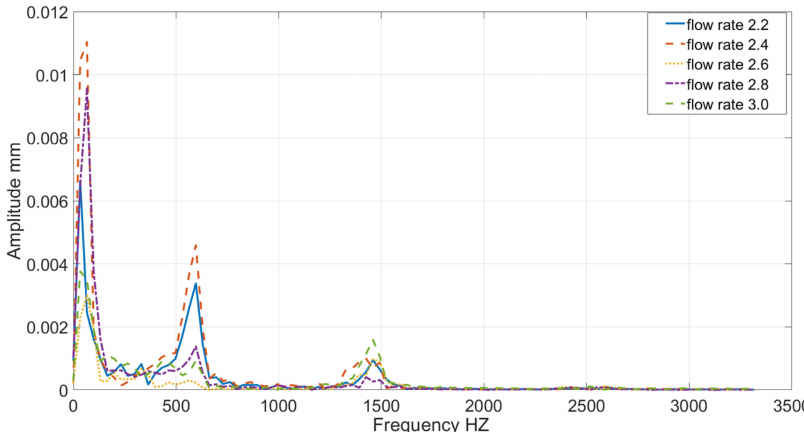
Figure 6. Spectral graph of displacements of sensor characteristic point C in Y direction under the impacts of different momentum